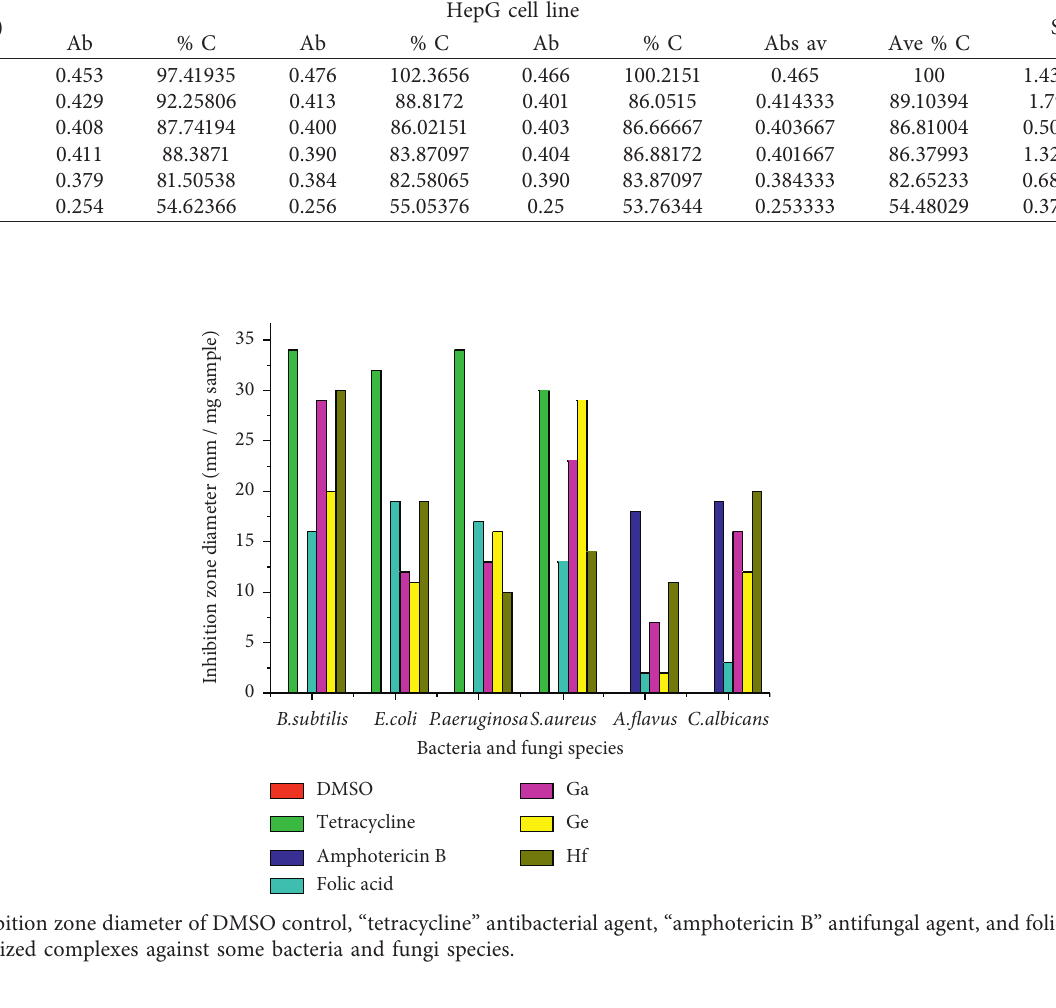
Table 7: The inhibitory activities of the Ge(IV) complex against HepG cell line. Conc. ( µ